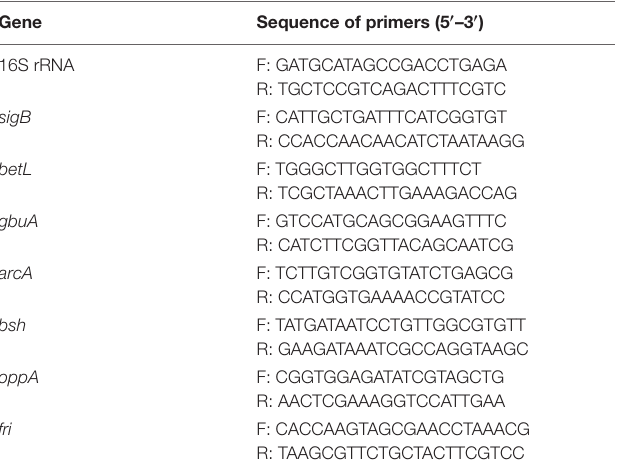
TABLE 1 | Primers used in this study for RT-qPCR